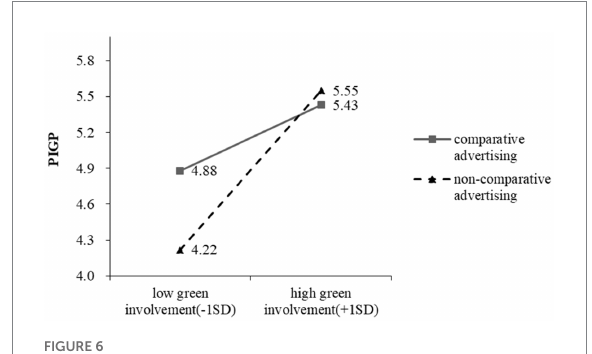
FIGURE 6 PIGP as a function of advertising types and green involvement.